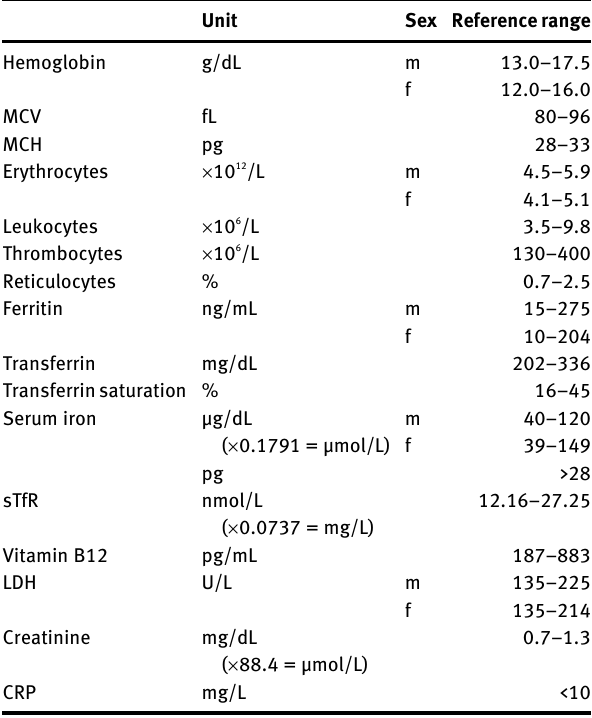
Table  : Reference ranges of the laboratory tests applied in this study.